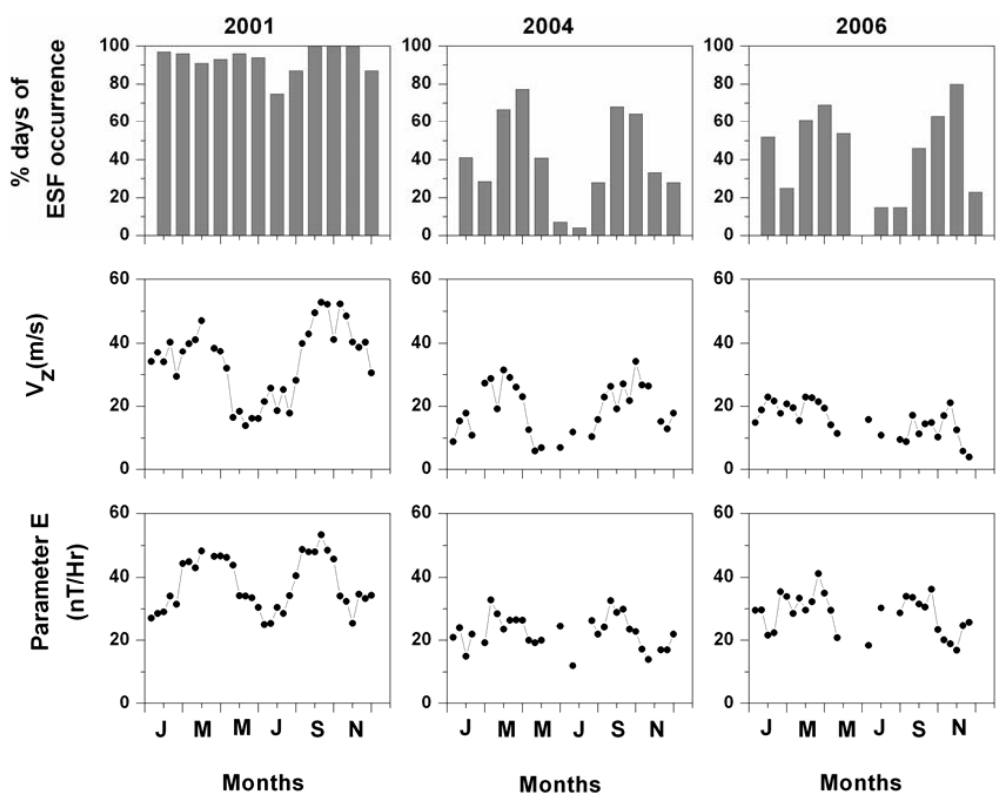
Fig. 3. The percentage of days of ESF occurrence on all the magnetically quiet days ( A p ≤ 20) of each month of 2001, 2004 and 2006 (top Figure 4(a): Scatter plot of the parameter ‘E’ versus V z for some international quiet days panel). The middle panel shows the 10 day mean variations in the V z values on ESF days of the month. The bottom panel shows an identical